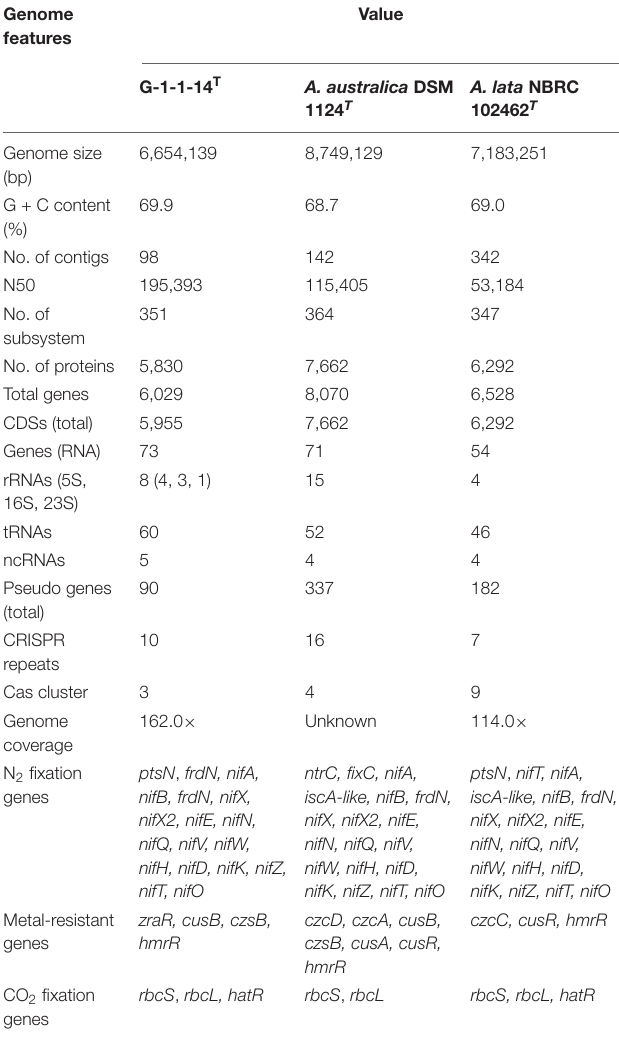
TABLE 1 | Genome features of strain G-1-1-14 T , Azohydromonas australica DSM 1124 T , and Azohydromonas lata NBRC 102462 T . Genome